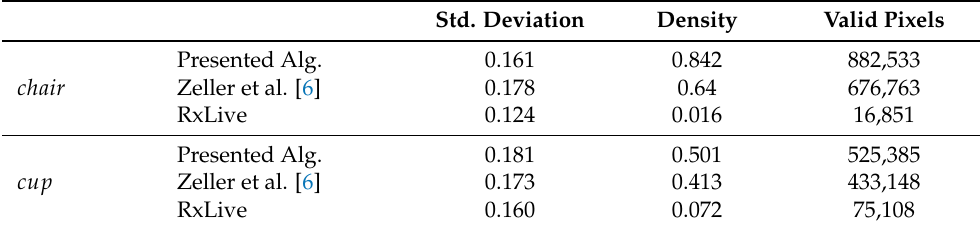
Figure 18. Raw image ( left ), filtered RxLive sparse depth map ( middle ) and filtered sparse depth map calculated by the presented algorithm ( right ). Table 2. Sparse depth map images